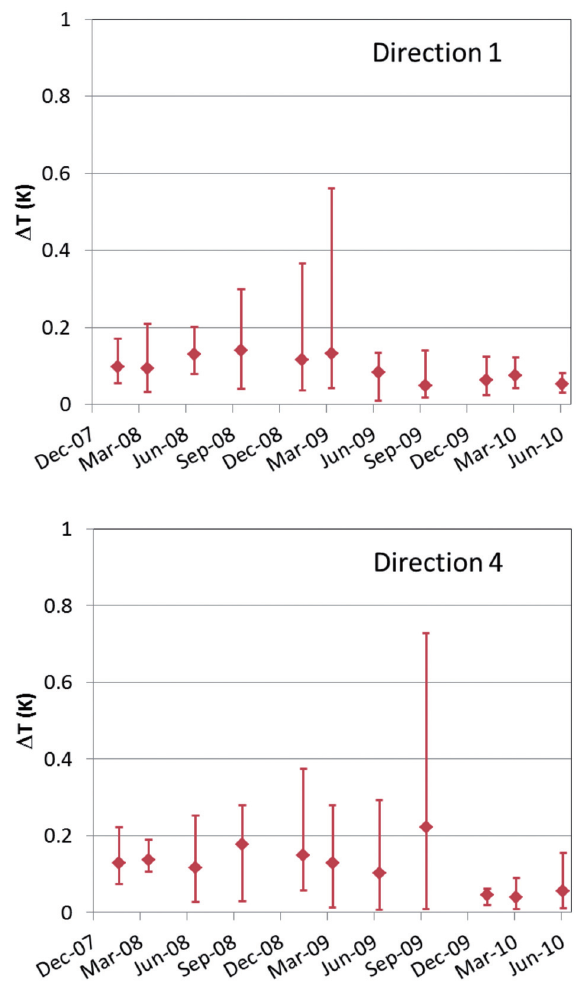
Figure 9. Computed DTb as a function of time for directions 1 and 4 for measurements performed with an observation angle of 42.5°.